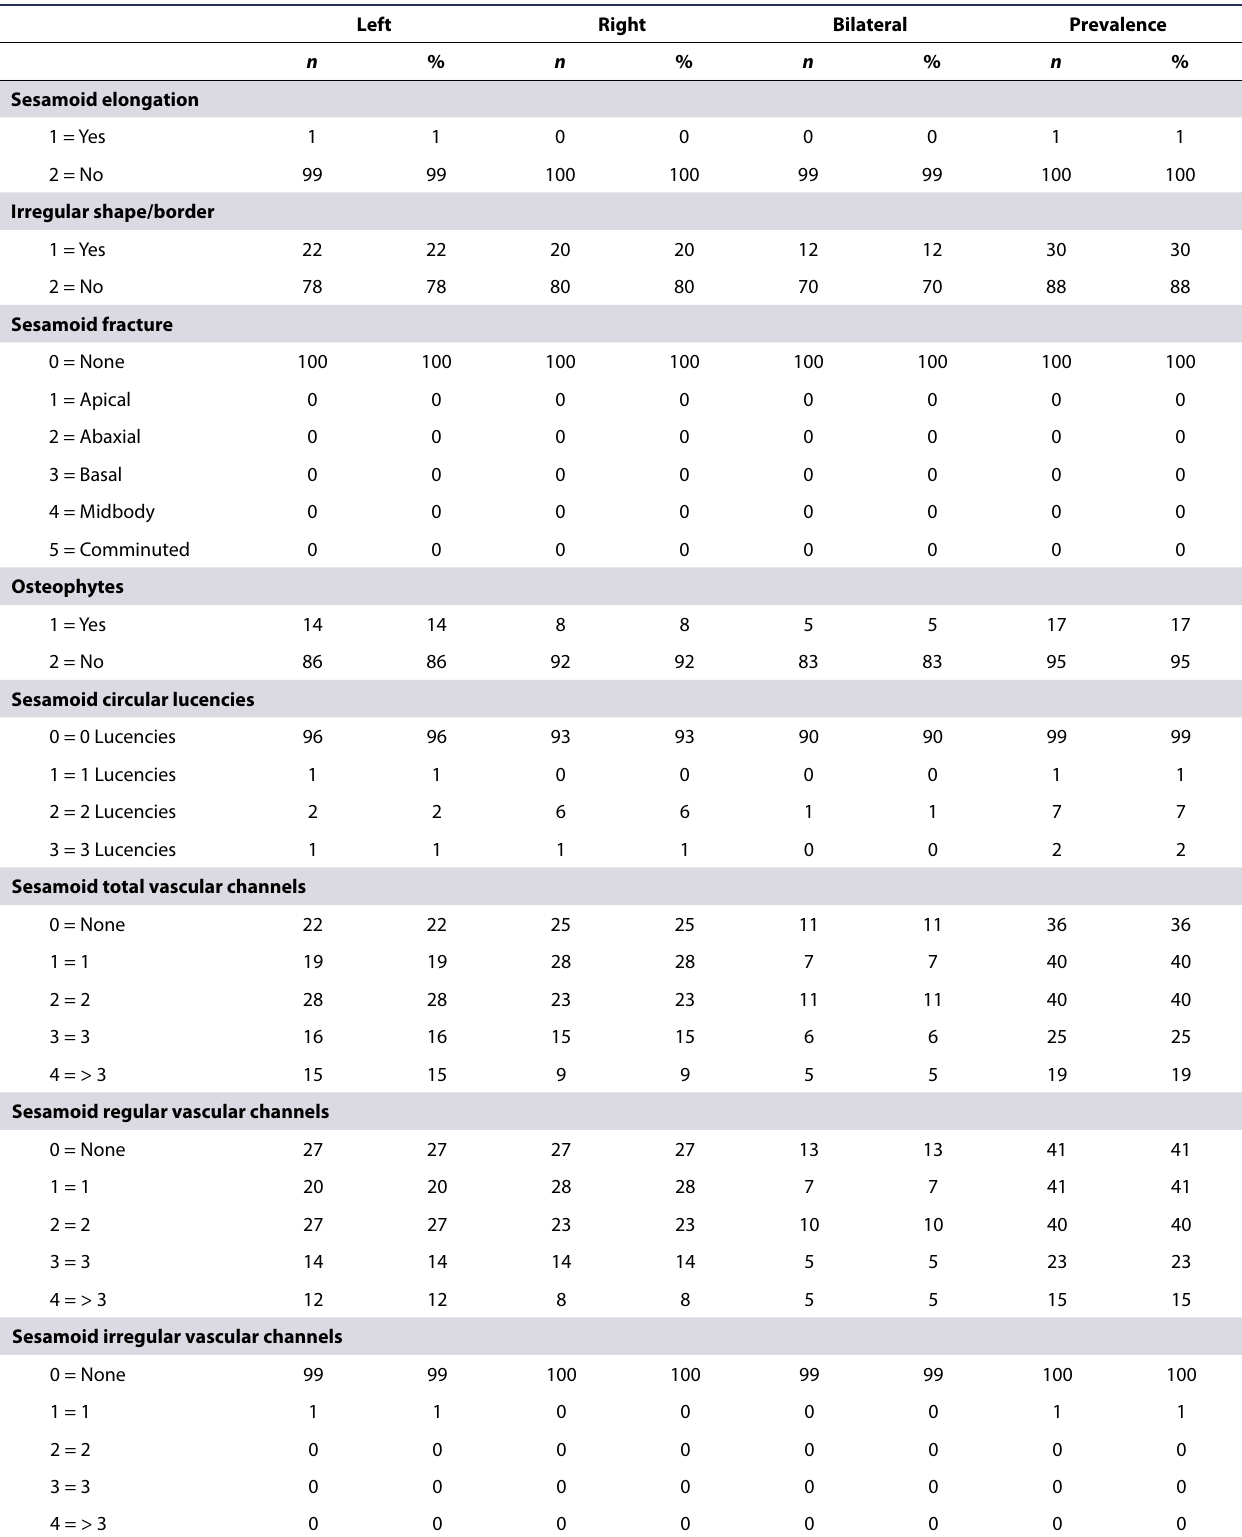
Table III: Radiographic changes in the proximal sesamoid bones of endurance racehorses ( n =100) Left Right Bilateral